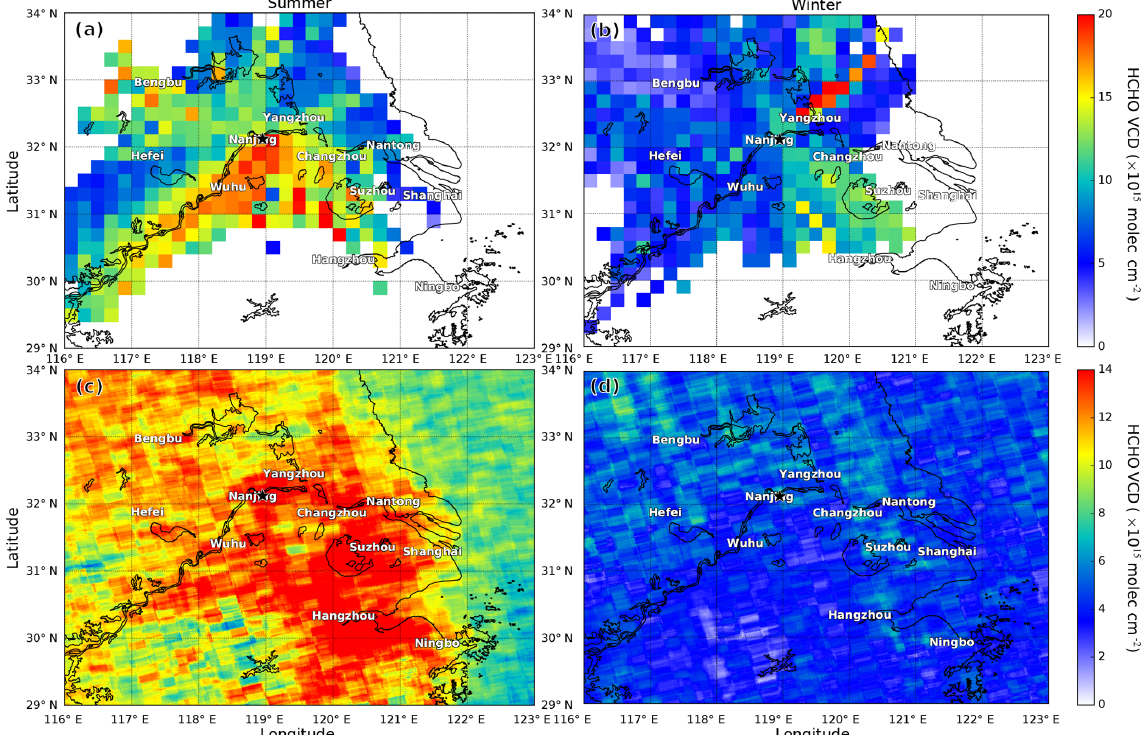
Figure 9. The upper panels show spatial distribution of HCHO in (a) summer and (b) winter reconstructed from the MAX-DOAS measure- ments using backward trajectories calculated by the HYSPLIT model. Backward trajectories are calculated over 6h for summer measure- ments and 12h for winter measurements. The lower panels indicates the average OMI HCHO vertical column densities over the Yangtze River Delta during (c) summer and (d)